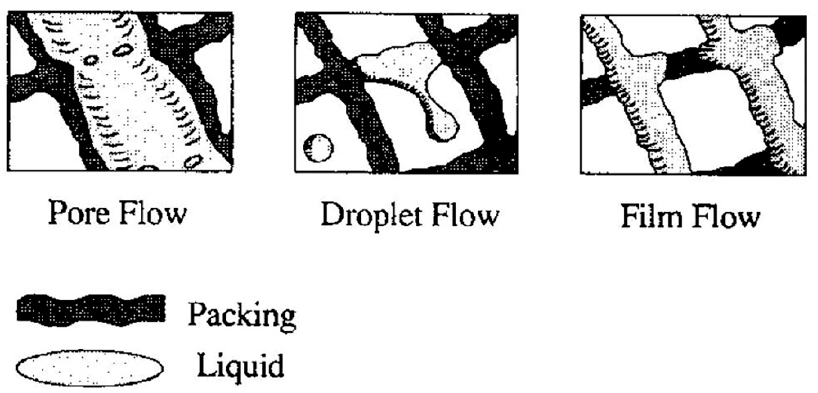
Figure 2. Three types of liquid pattern in RPB with a video camera, reproduced with permission from [3]. Copyright Elsevier, 1996.